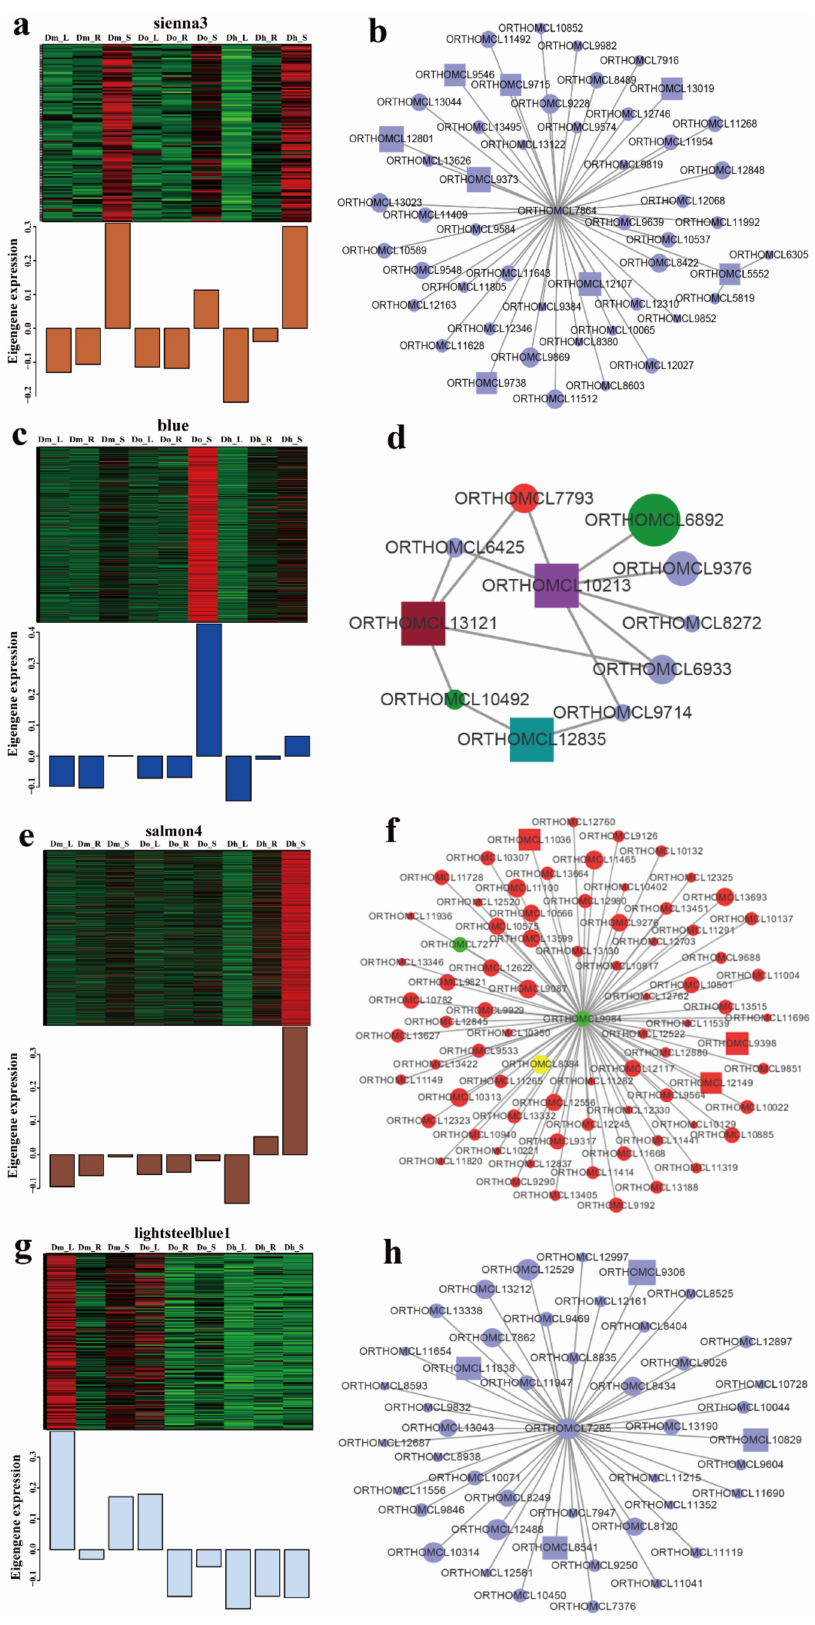
Figure 12. Expression profile and transcriptional regulatory network associated with the tissue-specific modules. ( a ), ( c ), ( e ), and( g )heatmapsshowinggenesinmodulethatweresignificantlyover-represented in Dm_L, Dm_R, Dm_S, Do_L, Do_R, Do_S, Dh_L, Dh_R, Dh_S and predicted transcriptional